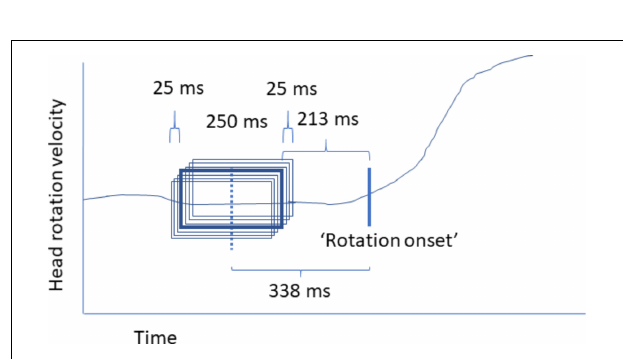
FIGURE 4 | Schematic overview of defining head rotation intervals for training the